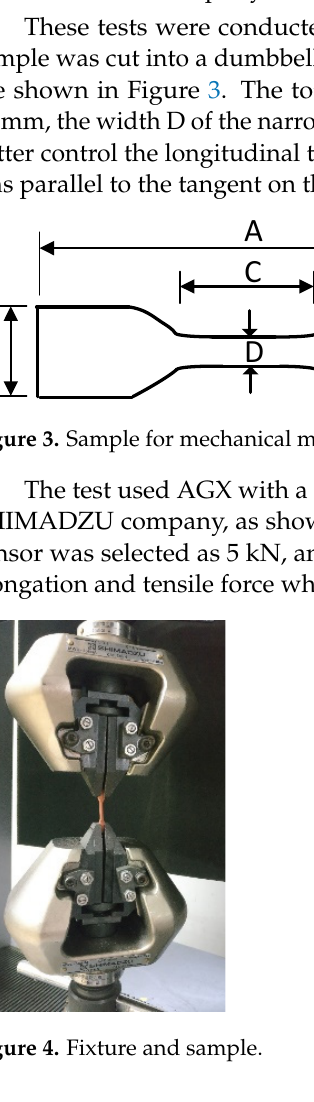
Figure 2. CPMG pulse sequence and echo.